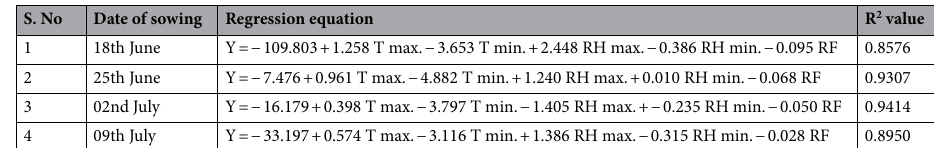
Table 5. Multiple regression equation for prediction of progress of Alternaria leaf spot severity at different dates of sowing in relation to weather parameters during Kharif , 2019.